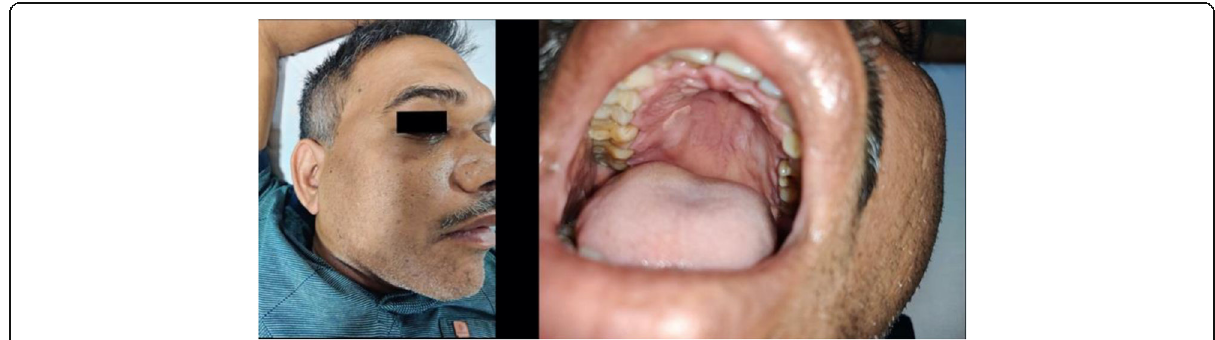
Fig. 1 Swelling of the right periorbital area with a plaque-like grayish lesion in the right palate